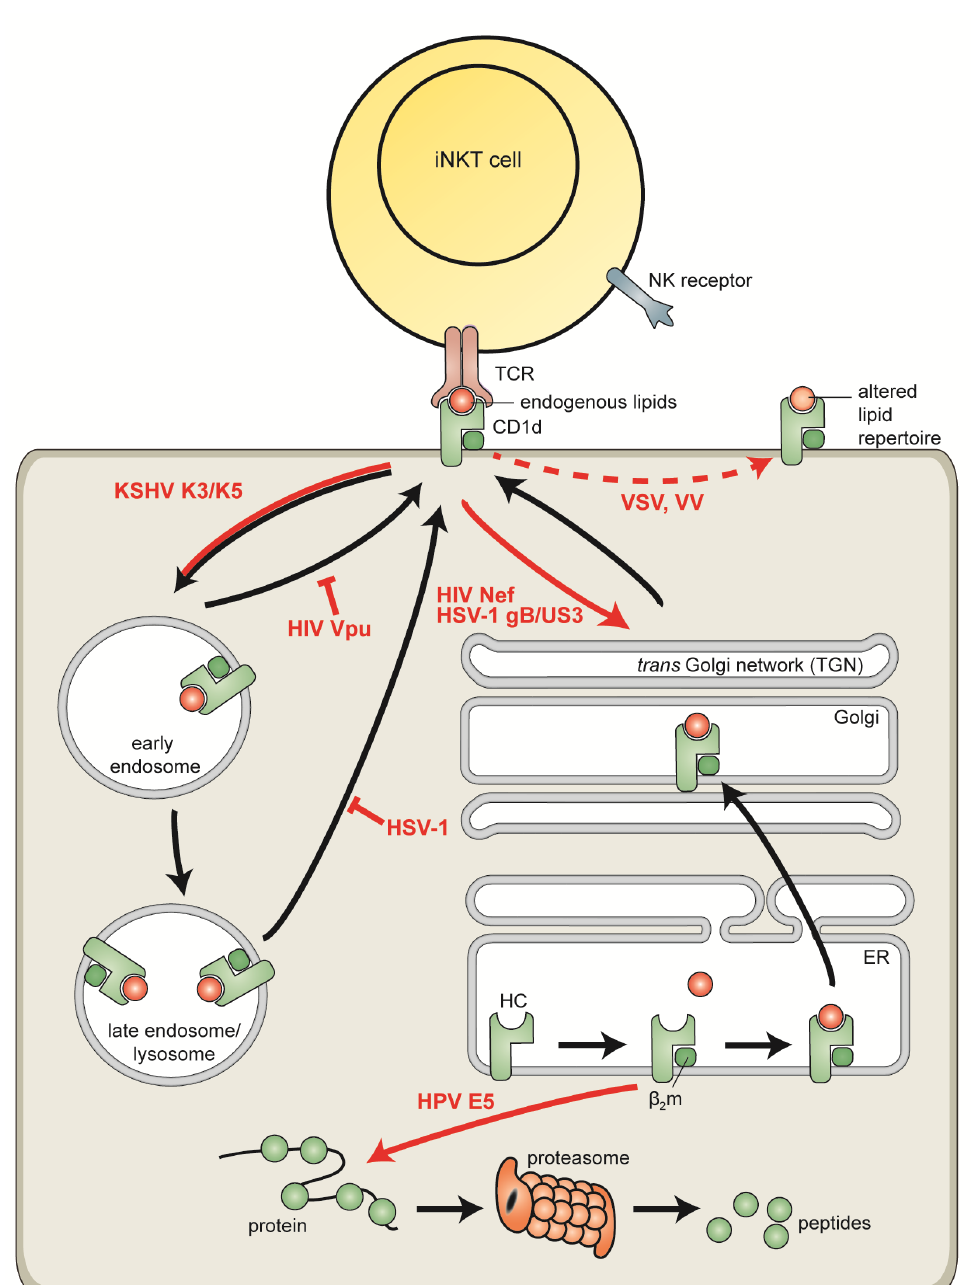
Figure 2. Viral evasion of CD1d-restricted lipid presentation to invariant natural killer T (iNKT) cells. Viruses subvert CD1d-restricted antigen presentation using different strategies: degradation of CD1d by cytosolic proteasomes (human papillomavirus (HPV) E5), redirection of CD1d to the trans -Golgi network (human immunodeficiency virus (HIV) Nef and herpes simplex virus type 1 (HSV-1) gB/US3), increased endocytosis of cell surface CD1d (Kaposi’s sarcoma-associated herpesvirus (KSHV) K3 and K5), inhibition of CD1d recycling from endolysosomal compartments to the cell surface (HIV Vpu and HSV-1), and modulation of MAPK-dependent CD1d trafficking, thereby presumably affecting the lipid repertoire presented by CD1d molecules (vesicular stomatitis virus (VSV) and vaccinia virus (VV)). HIV gp120 downregulates CD1d surface expression via an unknown